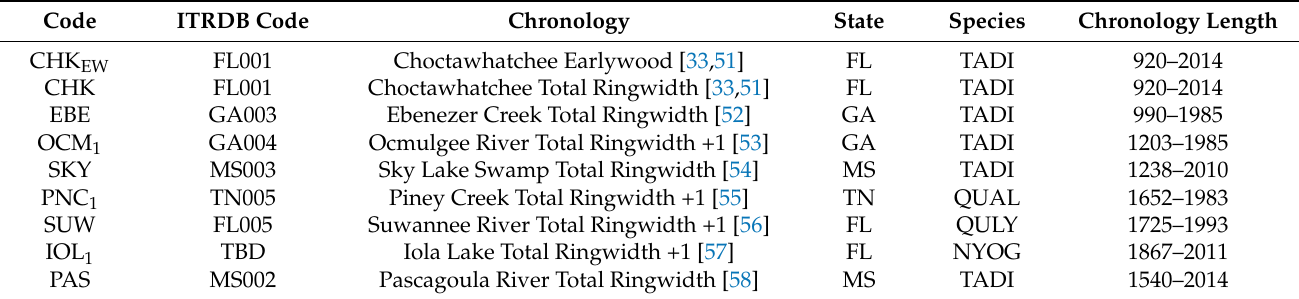
Table 2. Tree-ring chronologies (TRCs) retained in streamflow reconstruction models.